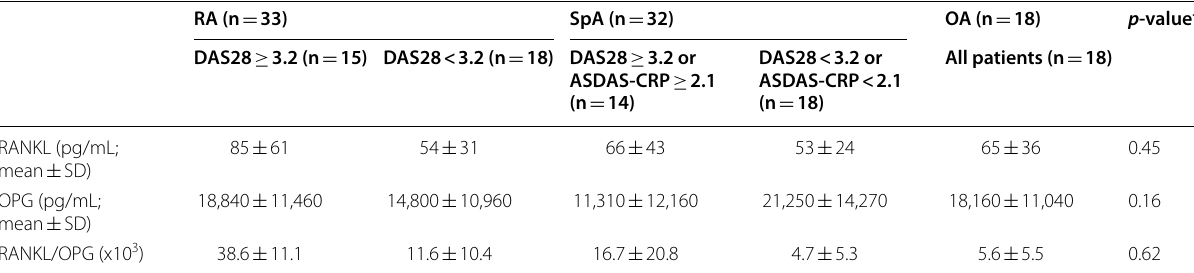
Table 2 Comparisons of RANKL, OPG and RANKL/OPG according to disease activity